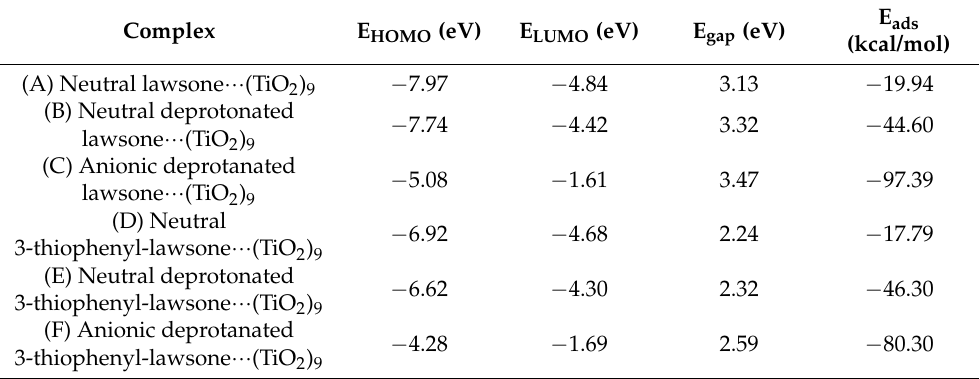
Table 6. Adsorption energies (E ads ), HOMO energies (E HOMO ), LUMO energies (E LUMO ) and gap HOMO-LUMO energies (E gap ) for the six complexes